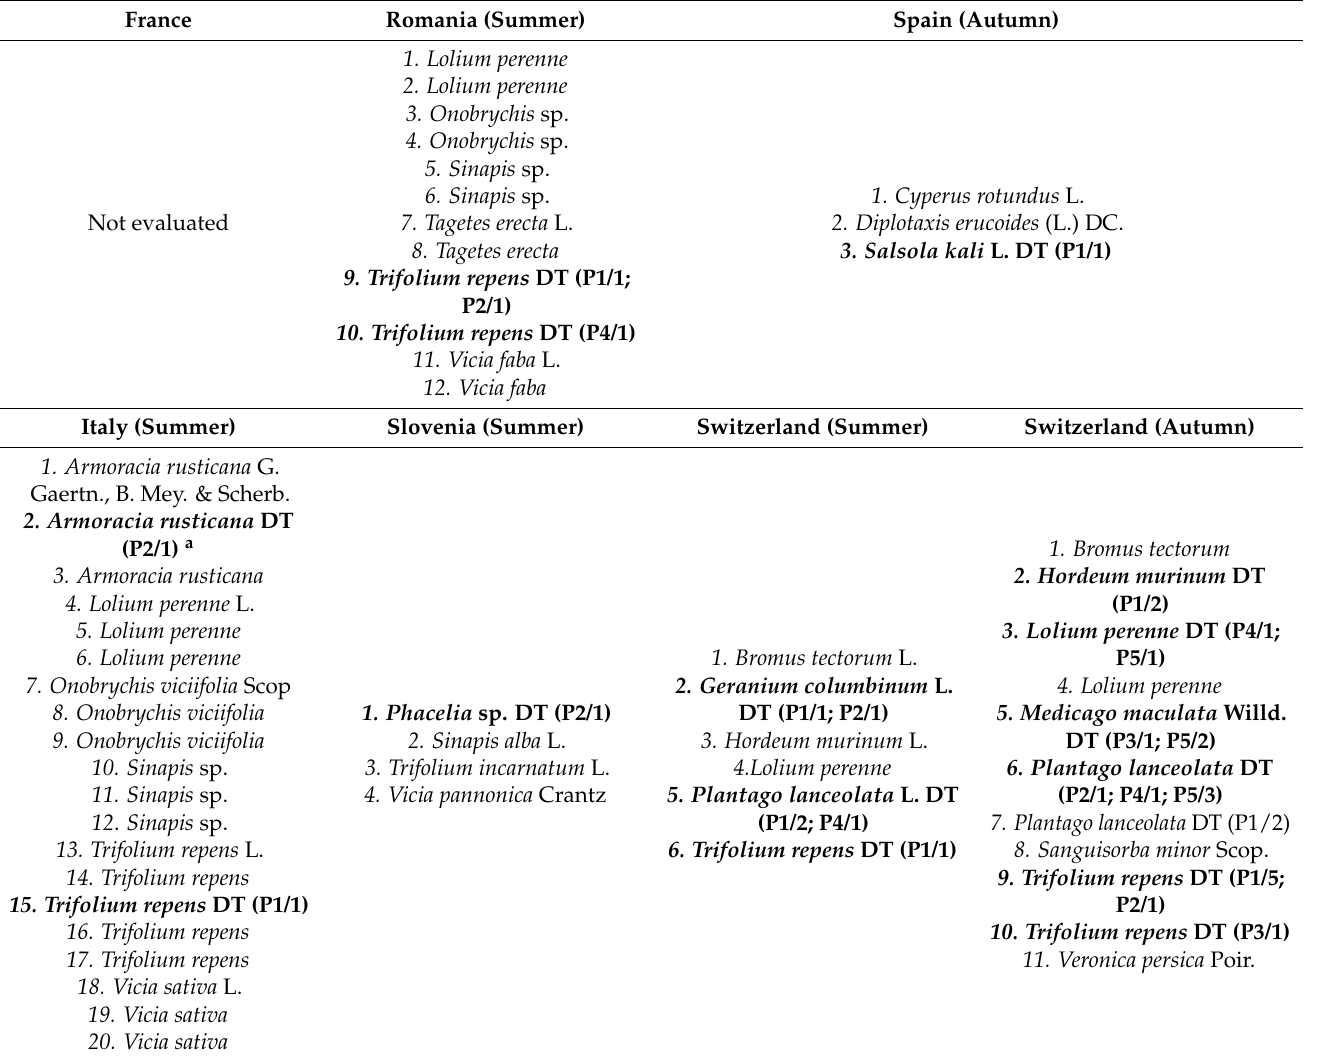
Table 2. Fifty-six samples of the planted and native cover crop species collected in experimental vineyards in six European countries in 2019, with indications of the Cylindrocarpon -like asexual morphs isolated from their roots. France Romania (Summer) Spain (Autumn)